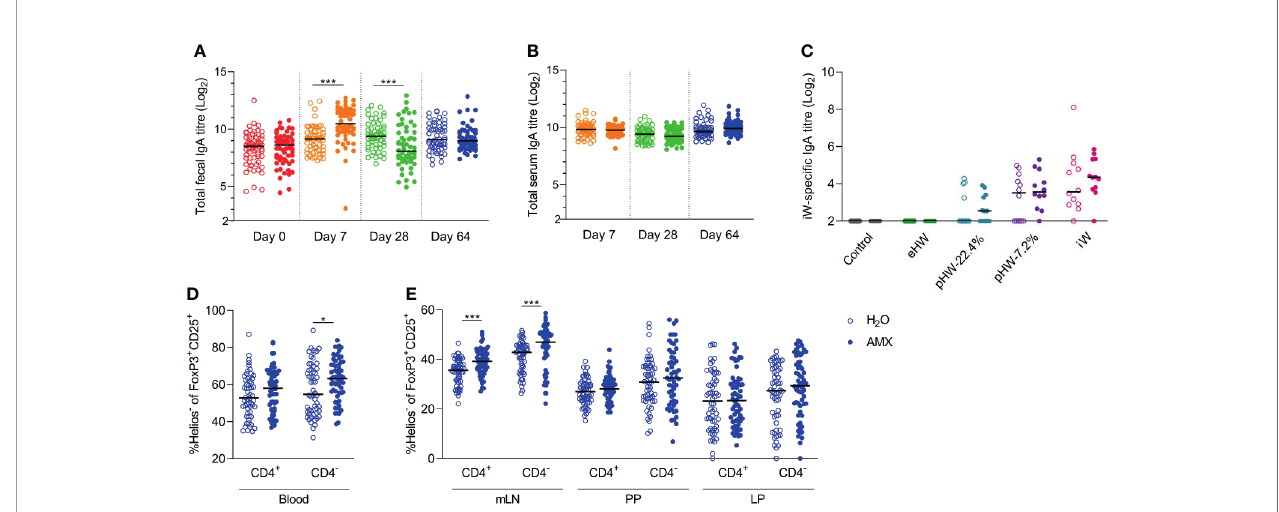
FIGURE 5 | Effect of amoxicillin administration on host immune regulation. Total faecal (A) and total serum (B) IgA titres in conventional (H 2 O, open symbols) or amoxicillin (AMX, closed symbols) groups. Intact whey (iW)-speci fi c serum IgA titres on Day 28 in rats administered with extensively (eHW), partially hydrolysed (pHW- 22.4% or pHW-7.2%) or intact (iW) whey products or water as control in their drinking water (C) . Fraction of Helios - Tregs out of the CD25 + FoxP3 + Treg populations (both CD4 + and CD4 - ) in blood (D) , and mesenteric lymph nodes (mLN), Peyer ’ s patches (PP) and lamina propria (LP) on Day 64 (E) . Each symbol represents a single rat and horizontal lines indicate median values. Statistically signi fi cant differences between groups are indicated as *p ≤ 0.05, ***p ≤